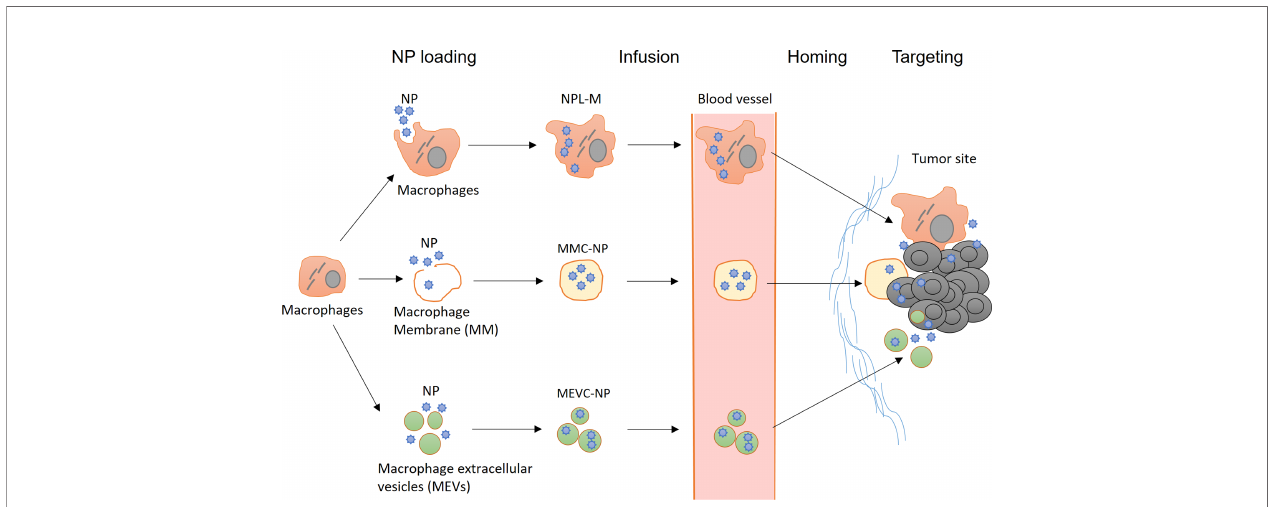
FIGURE 3 | Application of nanotechnology in the engineering of macrophages. (Top) After infusion, NPL-Ms actively migrate to tumor tissue and release NPs locally, resulting in enhanced antitumor effects. (Middle) Macrophage membrane-coated NPs (MMC-NPs) have a prolonged half-life in circulation and a strong af fi nity at the tumor site for vascular endothelial cells that facilitate their tumor site homing and accumulation. (Bottom) Macrophage-derived extracellular vesicle-coated NPs (MEVC-NPs) can in fi ltrate tumor sites, where they are taken up by tumor cells, inducing signi fi cant cell